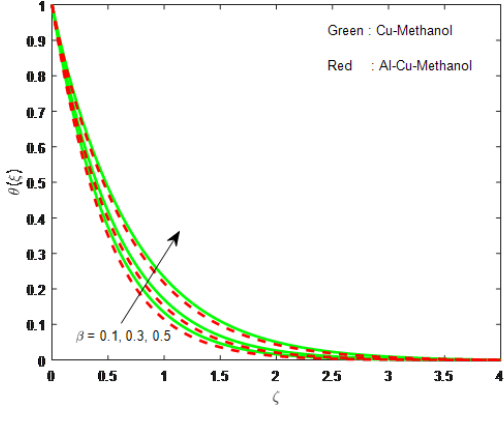
Fig. 4: Impression of β on θ ( ξ )